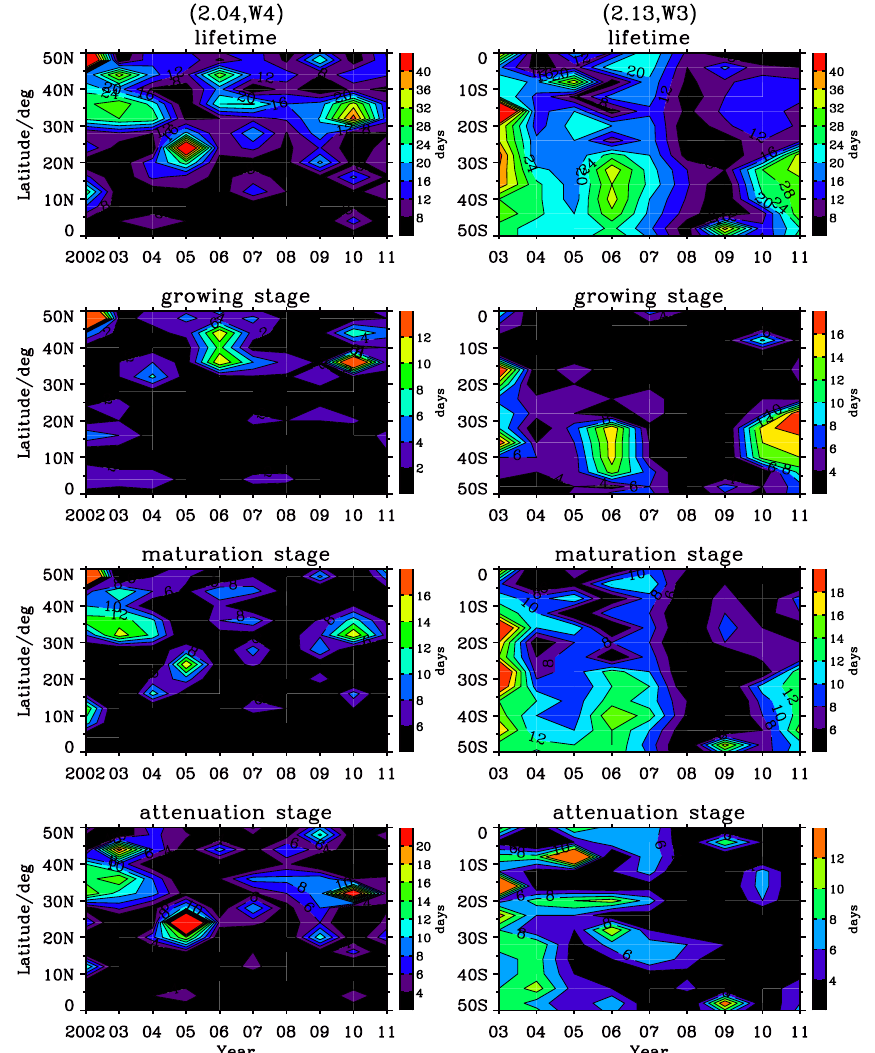
Fig. 9. Year–latitude cross sections of annual durations of lifetime (first row), growing stage (second row), maturation stage (third row) and attenuation stage (fourth row) for (2.04, W4) (left column) and (2.13, W3) (right column) at altitudes of their maximum